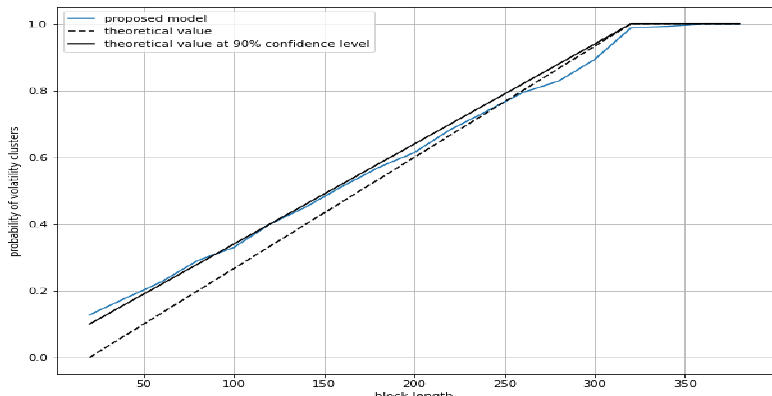
Figure 6. Probability of the existence of volatility clusters for an artificial process with volatility clusters of a fixed length (equal to 100, 200, and 300, from top to bottom).